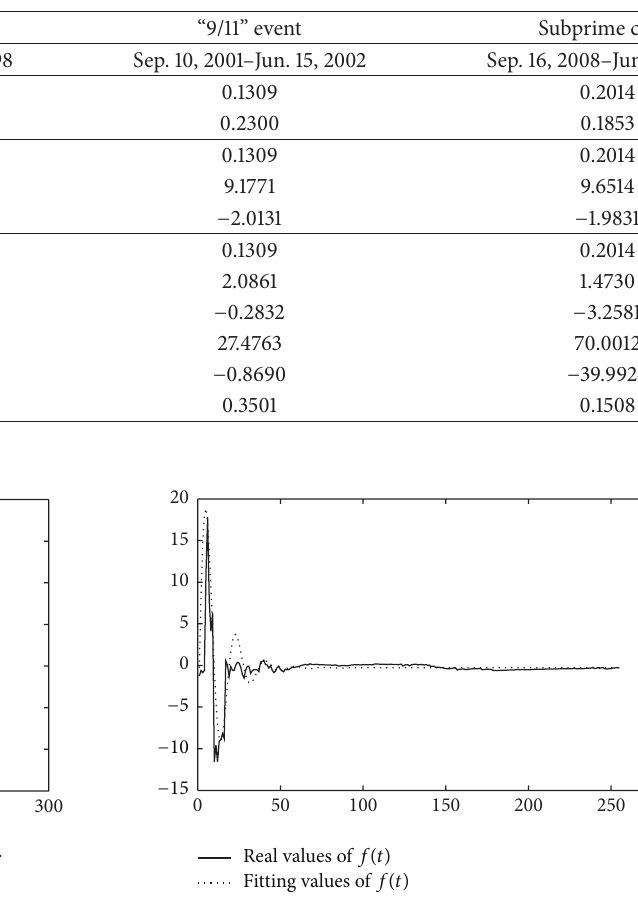
Table 1: Summary of parameter estimations.